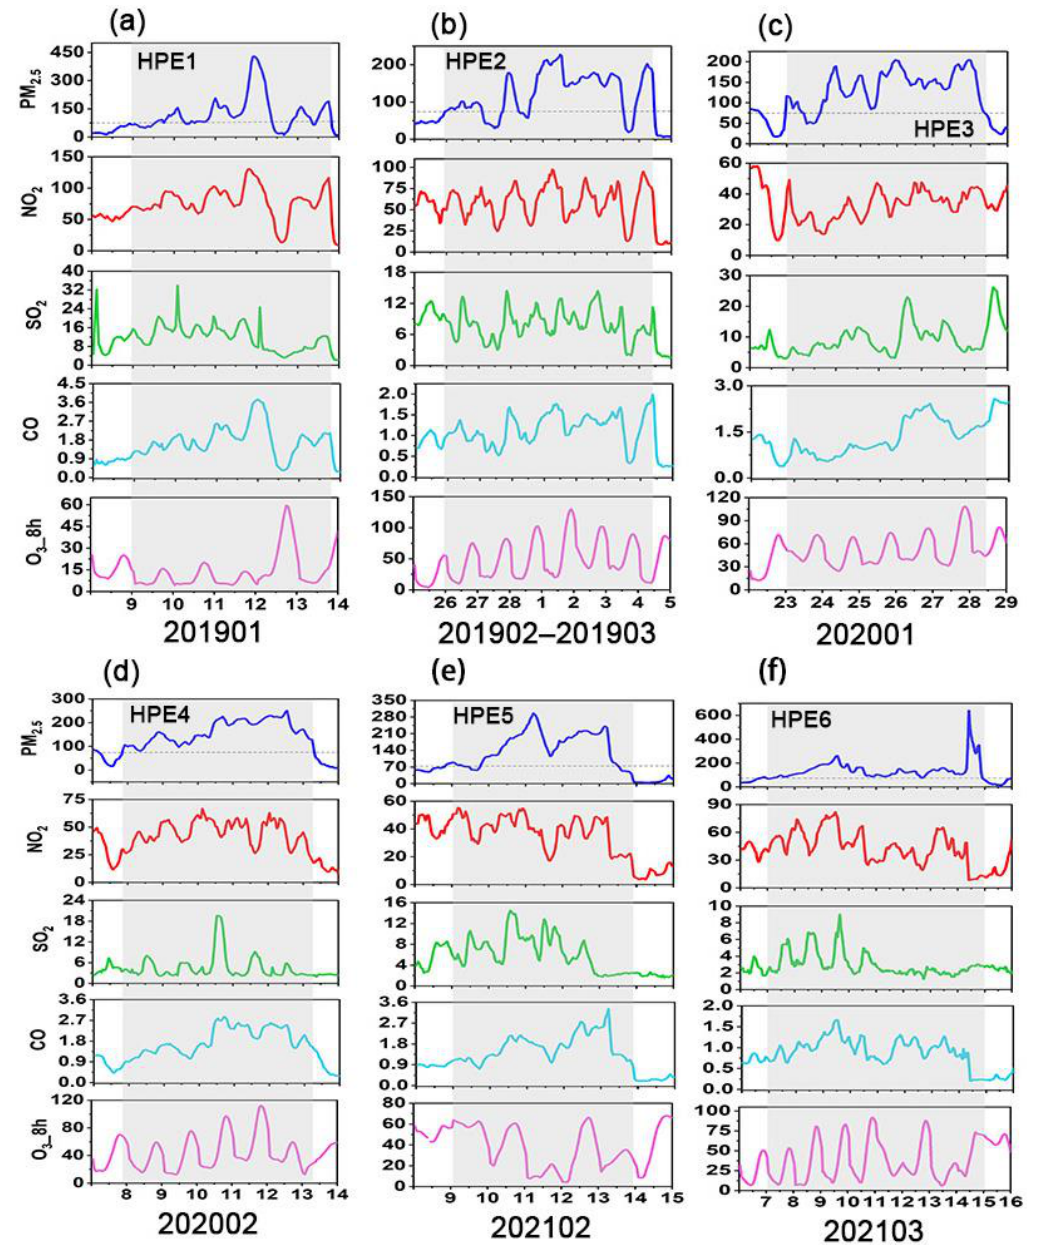
Figure 5. Time series of air pollutant concentrations during six heavy PM 2.5 pollution episodes (HPEs) in Beijing. ( a ) HPE1, ( b ) HPE2, ( c ) HPE3, ( d ) HPE4, ( e ) HPE5, and ( f ) HPE6. PM 2.5 , NO 2 , SO 2 , and O 3 _8h concentrations are in µ g m − 3 , and CO concentrations are in mg m − 3 . The ratio of PM 2.5 /CO is an indicator of secondary pollutants to primary emis- sions [65]. Specifically, the ratio of PM 2.5 /CO during six HPEs increased by 46.96%, 68.09%, 88.37%, 53.22%, 35.13%, and 42.46%, respectively, compared with the corre- sponding monthly average PM 2.5 /CO ratio. These pronounced increases in PM 2.5 /CO ratio further revealed the great contribution of secondary formation to heavy PM 2.5 pollution in Beijing. Consistently, studies have revealed that the persistent severe haze pollution in BTH and eastern China was associated with stronger secondary formation under a stagnant atmosphere despite the great reductions in primary emissions during the COVID-19 lockdown